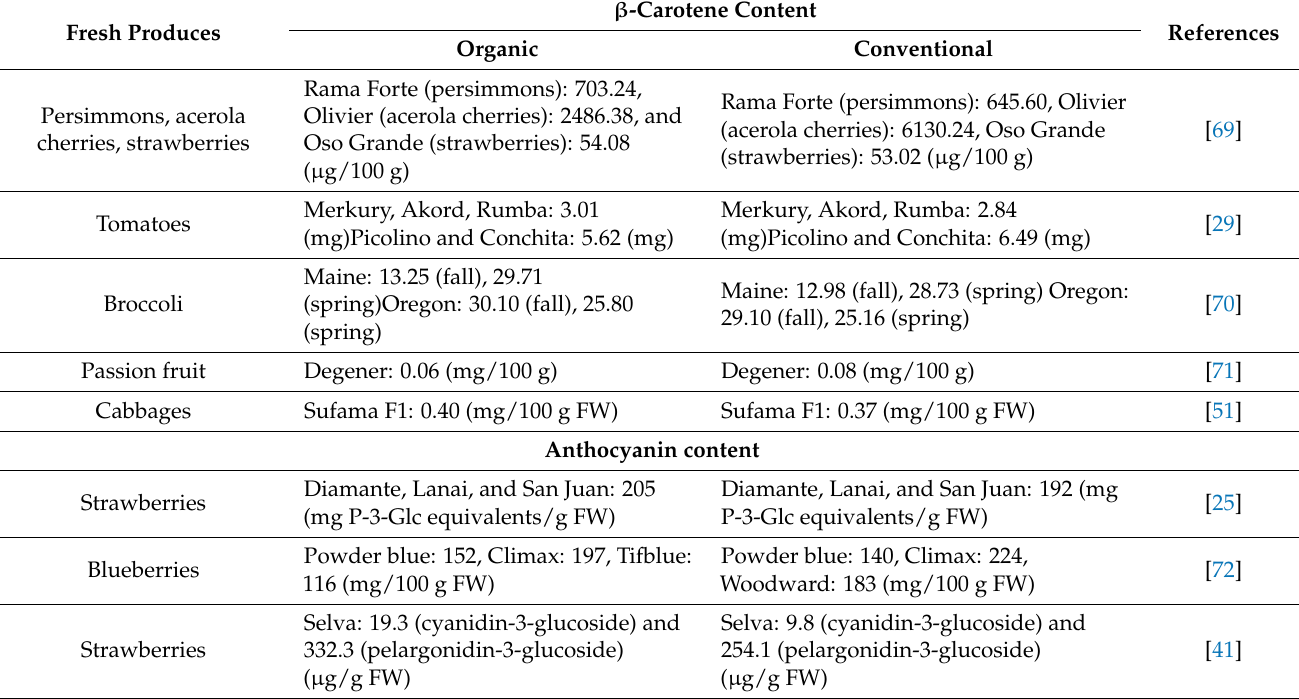
β -Carotene Content Conventional